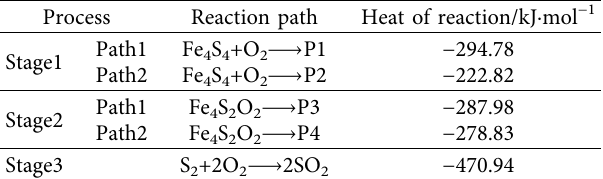
Table 3: Heat of reaction for each phase of the reaction.